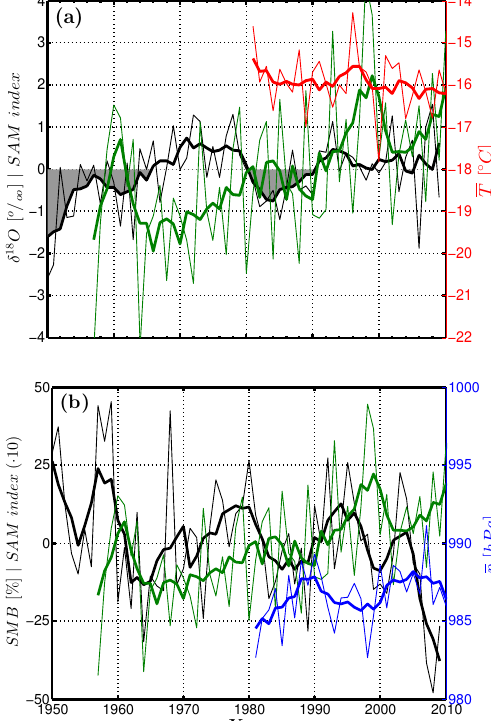
Figure 9. (a) Time series of mean annual δ 18 O of composite record Fig. 9. (a) Time series of mean annual δ 18 O of composite record Ice Shelves (black), annual mean ice shelves (black), annual mean air temperature of Neumayer Sta- air temperature of Neumayer station (red) and annual SAM index (green). (b) Mean annual SMB of tion (red) and annual SAM index (green). (b) Mean annual SMB of composite record Ice Shelves (black), annual mean pressure of Neumayer station (blue), and annual composite record ice shelves (black), annual mean pressure of Neu- SAM index (green). Bold lines: 5-year moving average mayer Station (blue), and annual SAM index (green). Bold lines: 5-year moving 38